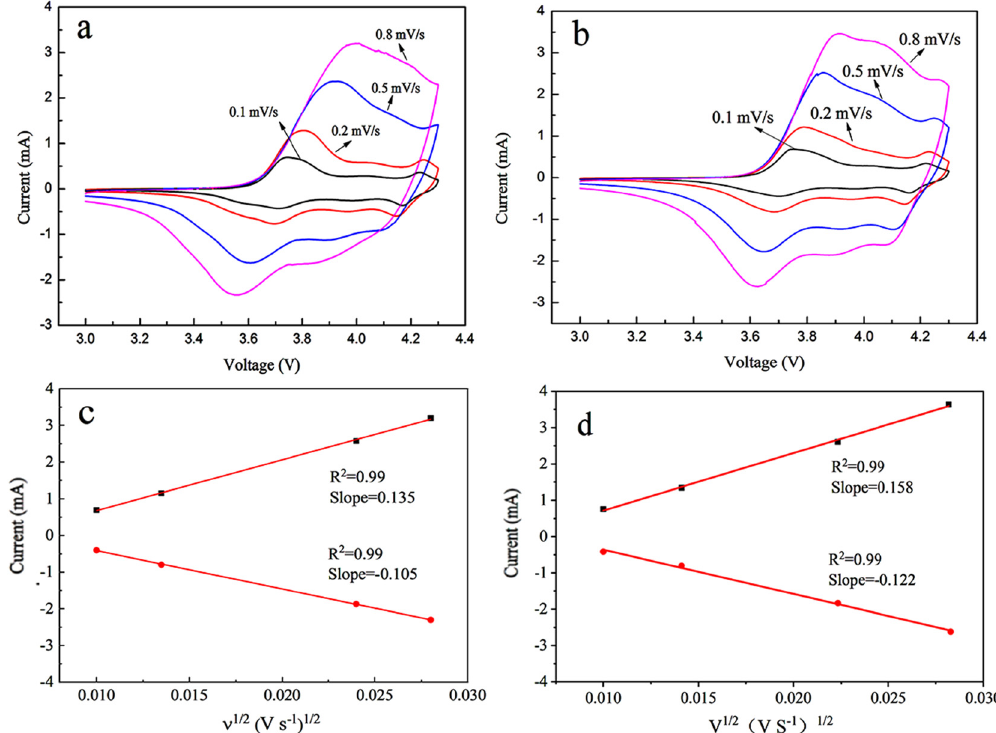
Figure 11: Cyclic voltammogram of ( a ) pristine and ( b ) ZnO - coated LiNi 0.8 Co 0.15 Al 0.05 O 2 at various scanning rates; linear relationship between the peak currents ( i p ) and square root of scan rate ( ν 1/2 ) : ( c ) pristine sample, ( d ) ZnO - coated LiNi 0.8 Co 0.15 Al 0.05 O 2 sample.